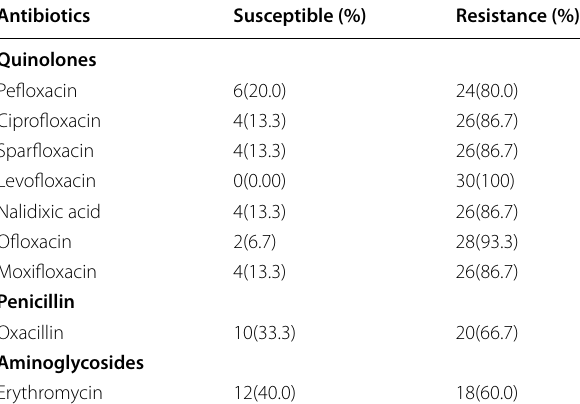
Table 3 The antibiotics susceptibility pattern of the 30 fluoroquinolone-resistant E. coli